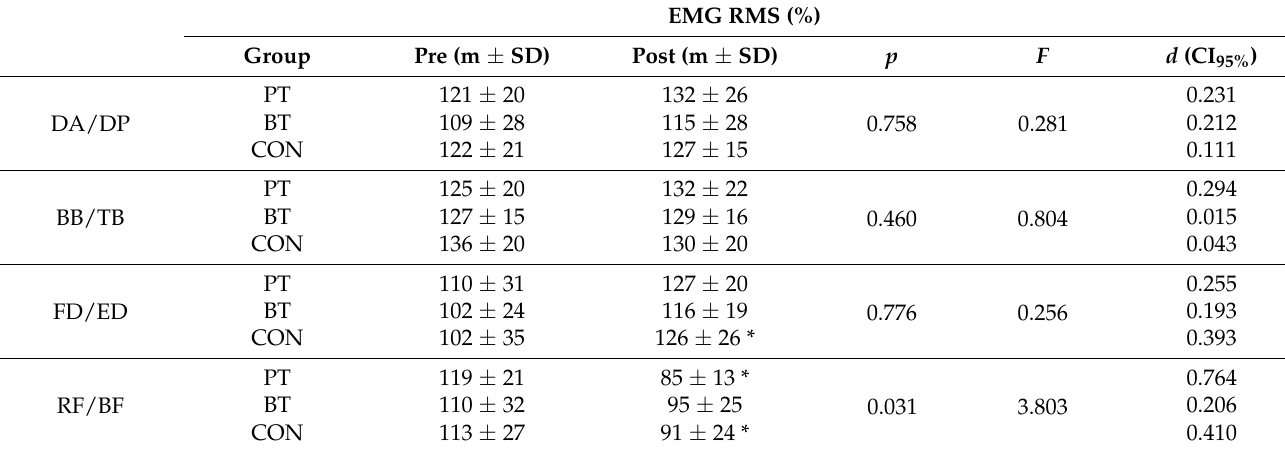
Table 8. Changes in the agonist/antagonist muscle ratio during the stroke test after the 8-week